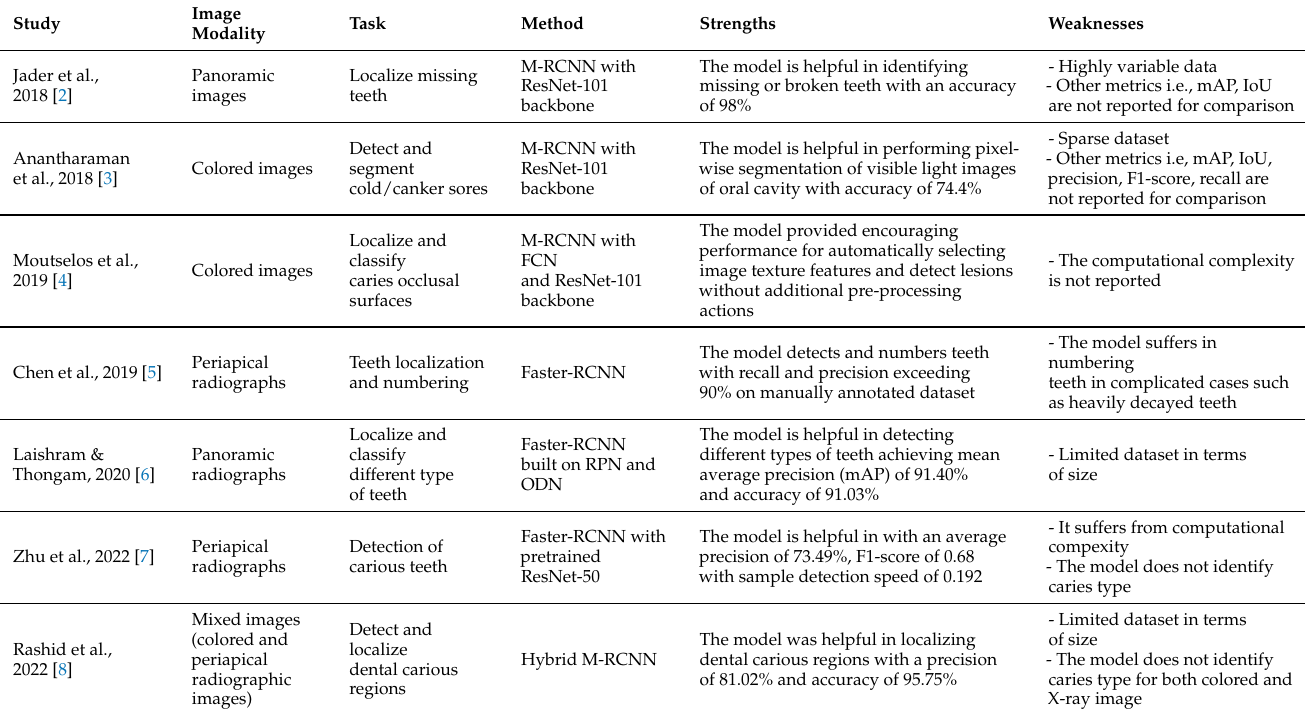
Table 1. Strengths and weaknesses of baseline dental lesion localization